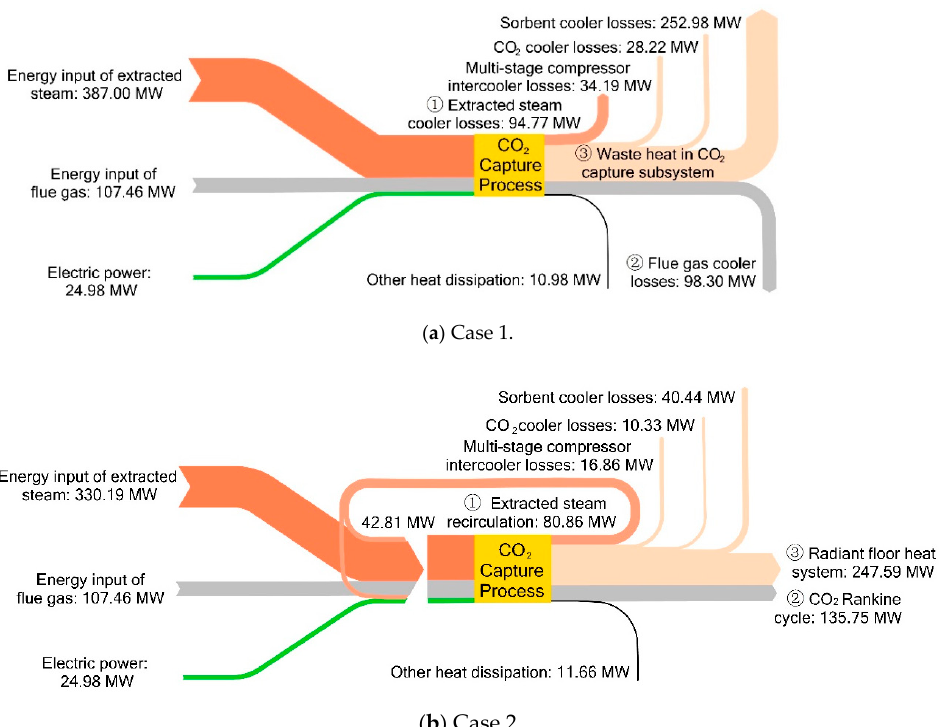
Figure 4. Energy flow diagram of the CO 2 capture process in ( a ) Case 1 and ( b ) Case 2.